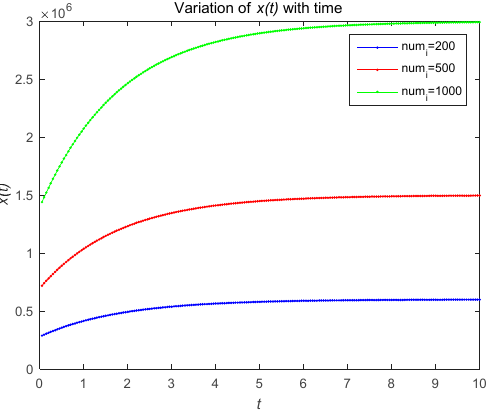
Figure 6. ( a ) Risk level variation for a system with one attacker; ( b ) risk level variation for a system with different numbers of attackers.